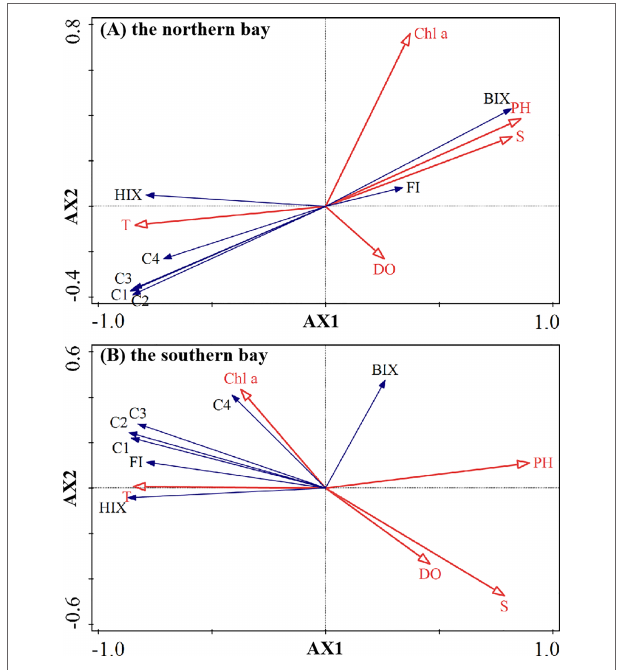
FIGURE 7 | The plots based on redundancy analysis in Zhanjiang Bay (the solid arrows with blue fonts are the response variables, and the hollow arrows with red fonts are the environmental